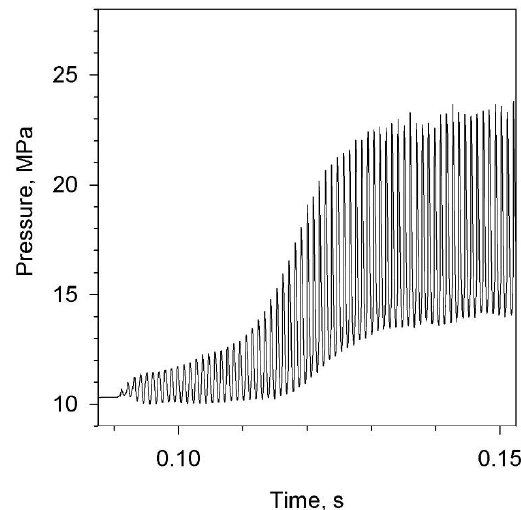
Figure 9. Predicted head-end pressure-time profile, reference motor ( K Δ H = 150,000 J/kg; Δ p s